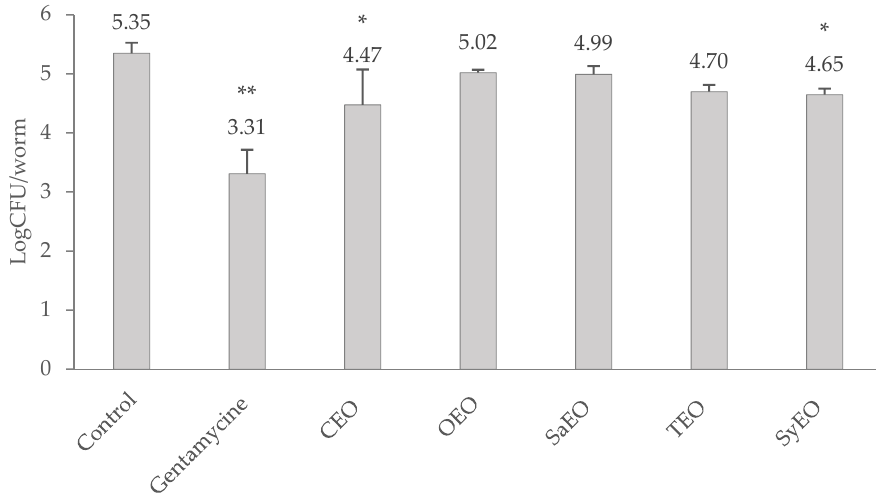
Figure 1. Evaluation of the bacterial load in the digestive tract of Caenorhabditis elegans infected with Salmonella enterica sv Typhimurium, after a 24 h treatment with essential oils. CEO, OEO and SaEO are tested at 50 µg/mL, TEO at 100 µg/mL, and SyEO at 150 µg/mL. Untreated nematodes are used as negative control, and gentamicin at 50 µg/mL is used as positive control. Values in LogCFU/nematode are means ± SD ( n = 6). * p < 0.05, ** p < 0.01.